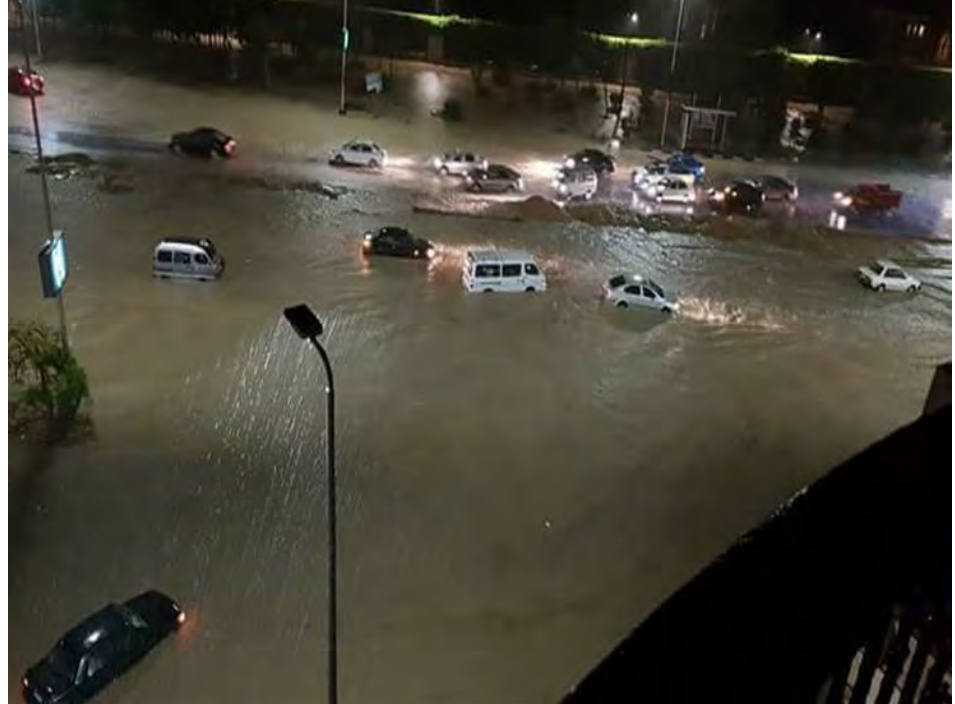
Fig. 6: Sinking of main street. (Masrawy.com,